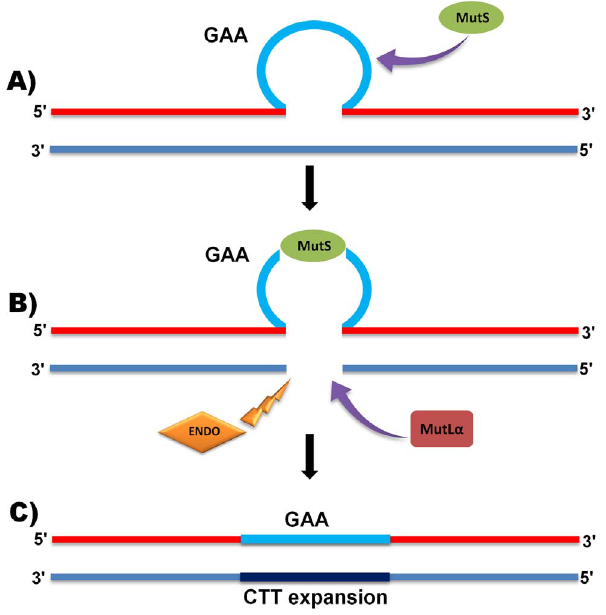
Figure 7. Proposed mechanism of MMR action on post-mitotic somatic GAA repeat expansions. Images represent: ( A ) a small GAA loop is formed as part of the triplex DNA N RNA R-loop structure caused by transcription within GAA repeats; ( B ) recognition of the small GAA loop by MutS-heterodimers, cleavage of the CTT DNA strand with an endonuclease (ENDO) and recruitment of MutL a , and ( C ) release of the RNA, synthesis of expanded DNA and end of repair by ligation of the expanded strand and release of MMR proteins.